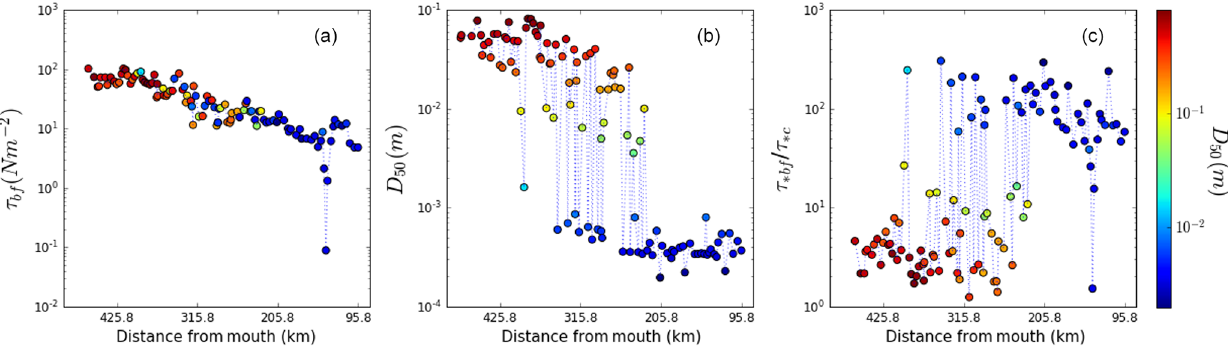
Figure 6. Longitudinal profile data from the Sacramento River up to approximately 500km upstream of the river mouth (Singer, 2010). (a) Fluid shear stress decreases gradually and continuously across the gravel–sand transition. (b) Grain size behavior downstream is bimodal, changing rapidly from gravel to sand. (c) Shields stress shows abrupt transition from near threshold to far above threshold across the gravel– sand